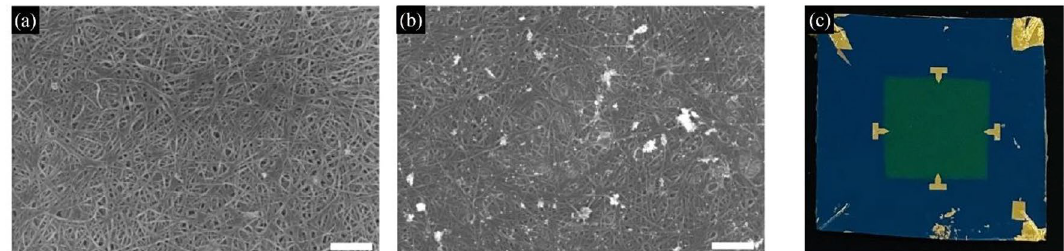
Figure 1. The SEM analysis pictures taken from the mCNT samples without ( a ) and with ( b ) gold nanocrystals (the white areas). The scale bars are 400 nm. ( c ) Photograph of the representative sample of thin carbon nanotube film with four contacts located at the edges of the